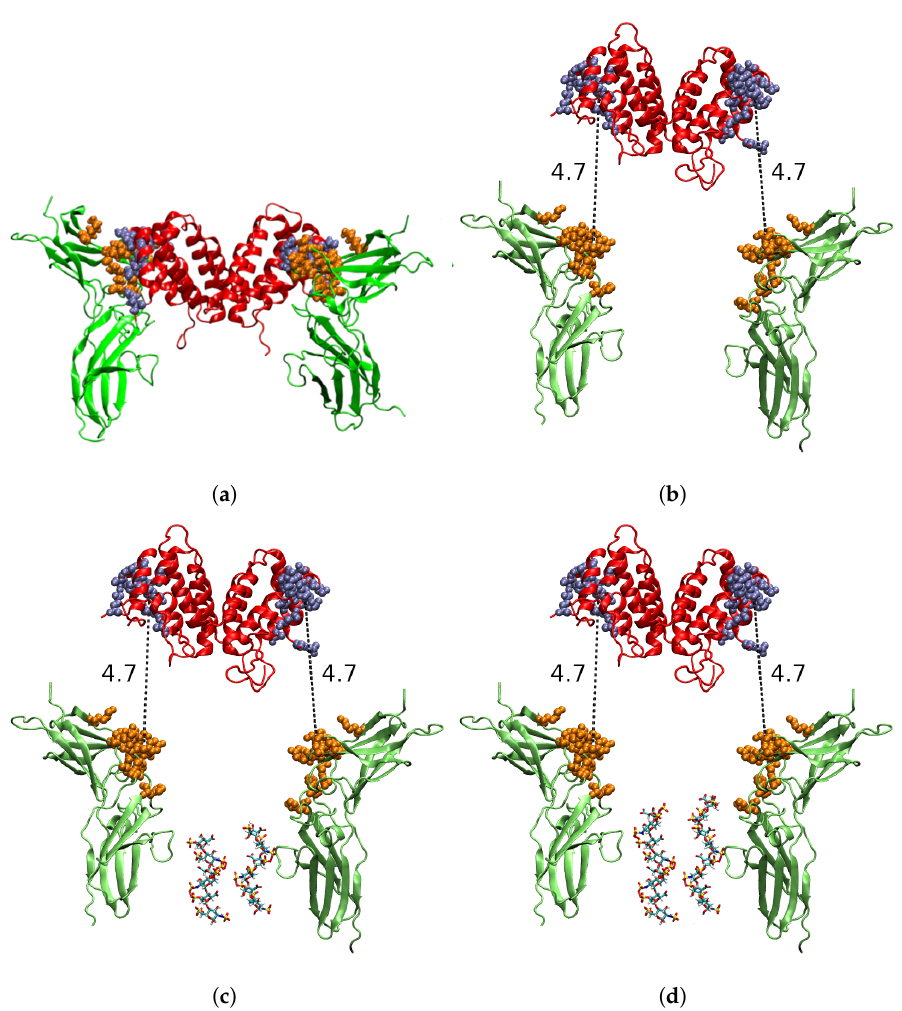
Figure 1. Initial models used to study the binding of hIFN γ to hIFNGR1 in different scenarios: ( a ) reference simulation based on the crystallographic structure of the complex; ( b ) binding of the full-length hIFN γ to its receptor; binding of the full-length hIFN γ to its receptor in the presence of HS-derived ( c ) hexa- or ( d ) octasaccharides. The cytokine and the receptor subunits are presented in red, resp. green cartoons. The amino acid residues in hIFN γ and hIFNGR1 molecules, partici- pating according to [12] in the binding, are shown in blue, resp. orange spheres. The HS-derived oligosaccharides are colored by atom type and presented as